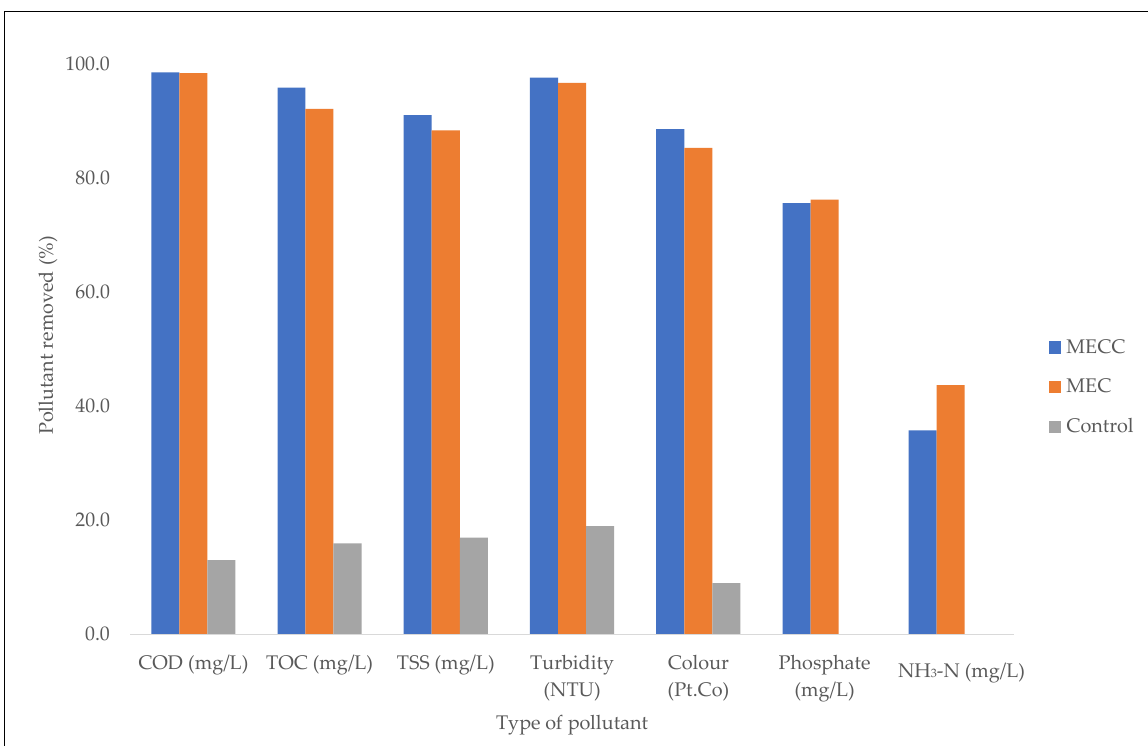
Figure 9. Effect of configuration on pollutant removal.